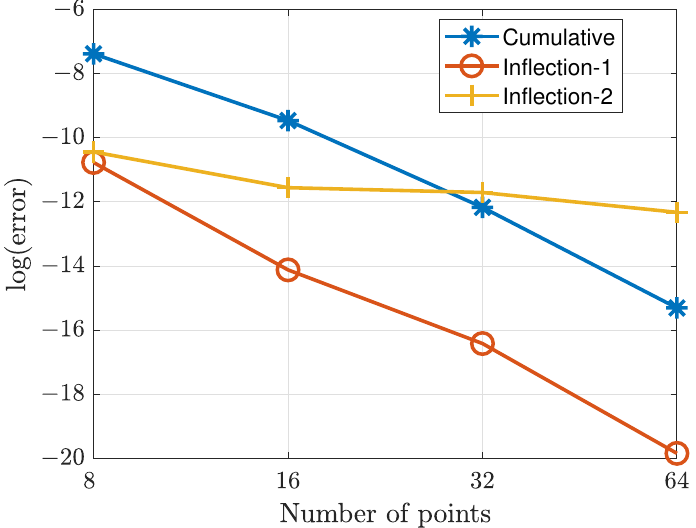
Figure 15. Tabular approximation error vs. number of